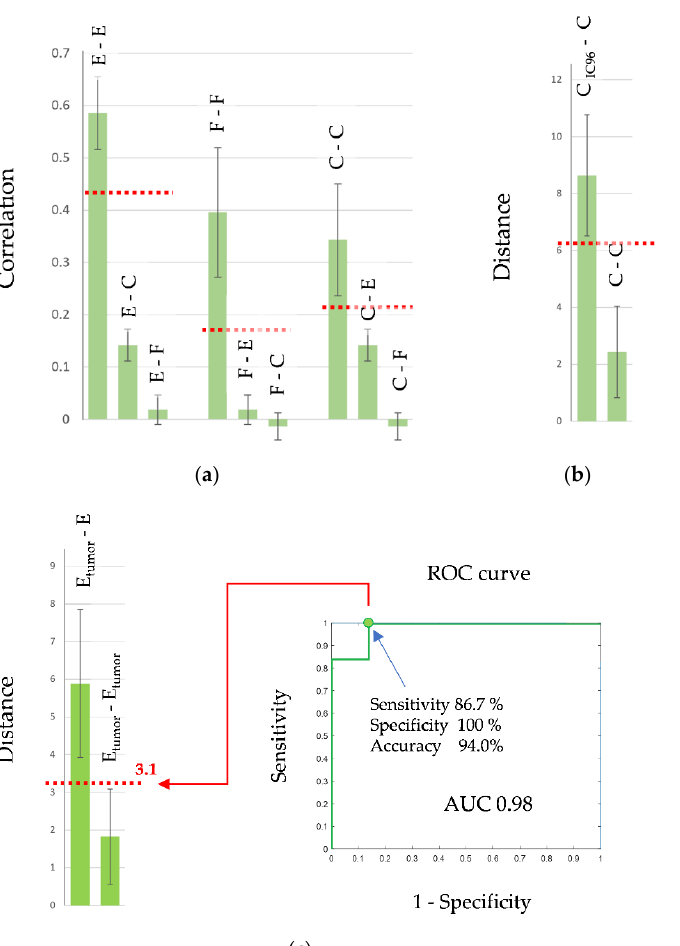
Figure 6. CPF authentication of cell type and subpopulation. ( a ) Cell type authentication. Footprints of endothelial cells correlate with each other (E-E) with higher correlation coefficients than with cancer cells (E-C) and fibroblasts (E-F). The footprints of fibroblasts correlate with each other (F-F) with higher correlation coefficients than with endothelial cells (F-E) and cancer cells (F-C). Foot- prints are taken from [31,46,80]. ( b ) The authentication of a subpopulation of cancer cells (MCF-7). The distance from the footprints (scores on PC1) of the drug-selected subpopulation (selection with an IC96 dose of etoposide) to other subpopulations of cancer cells is higher (C IC96 -C) than the dis- tance between cancer cells in the ‘other’ subpopulations (C -C). Footprints are taken from [80]. ( c ) The authentication of a subpopulation of endothelial cells (HMECs). The distance between the foot- prints (scores on PC2) of endothelial cells with the tumor-induced phenotype (E tumor -E tumor ) is lower than the distance from them to other subpopulations of endothelial cells (E tumor -E). Footprints are taken from [31]. An ROC curve is used to find the optimal threshold value (red dotted lines) to separate footprints according to the cell type and subpopulation. The provided data are consistent with the data presented in Tables 1 and 2.